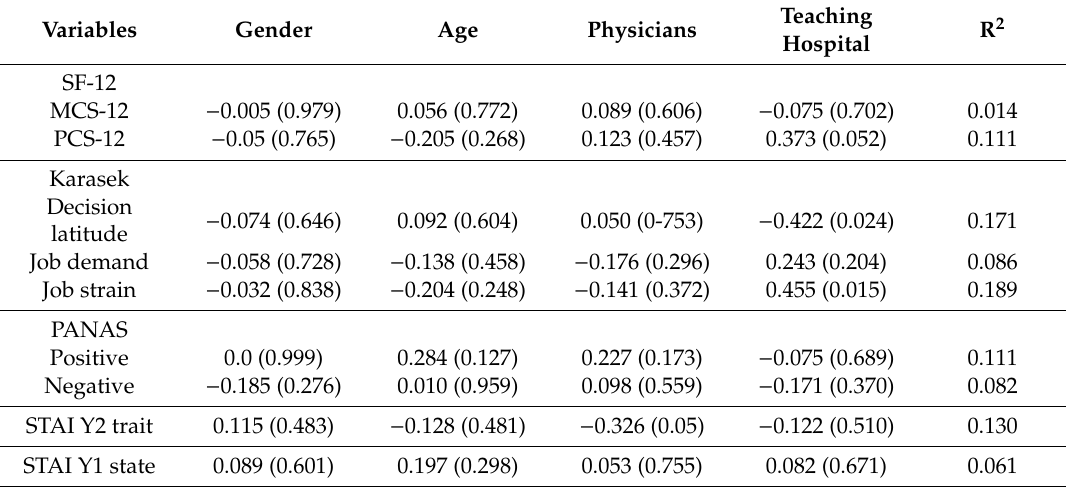
Table 3. Multivariate analysis—linear regression analysis on the delta (pre-and postintervention di ff erence)